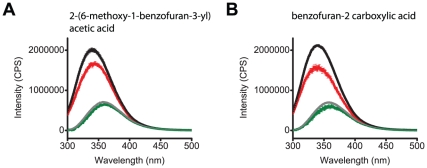
2-(6-methoxy-1-benzofuran-3-yl) acetic acid and benzofuran-2 carboxylic acid reduced fluorescence of mEAG1#505-702.The inner filter corrected, and background subtracted emission spectra of mEAG1#505-702 recorded without (black) and with (red) 30 µM 2-(6-methoxy-1-benzofuran-3-yl) acetic acid (A), and 50 µM benzofuran-2 carboxylic acid (B). Also shown are the inner filter corrected, and background subtracted emission spectra of free tryptophan recorded without (grey) and with (green) 30 µM 2-(6-methoxy-1-benzofuran-3-yl) acetic acid (A) and 50 µM benzofuran-2 carboxylic acid (B).